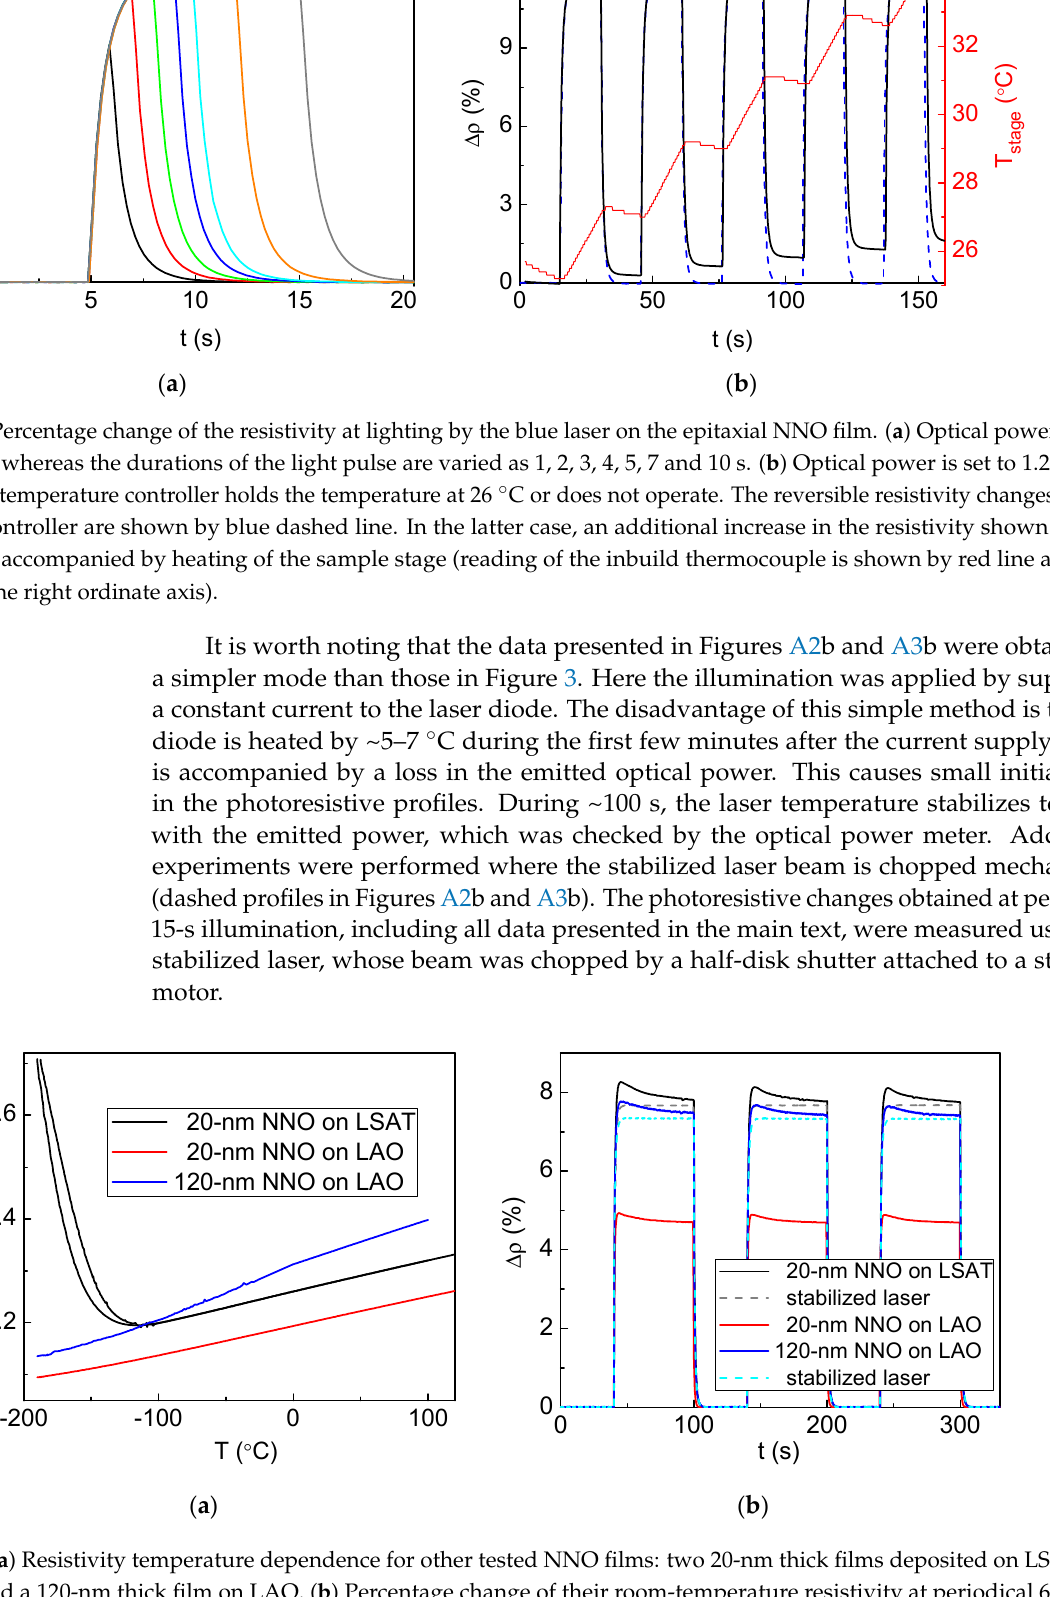
( b ) Figure A3. ( a ) Resistivity temperature dependence for other tested LNO films: two films deposited on LSAT with thick- nesses 20 and 80 nm as well as a 120-nm thick film on LAO. ( b ) Percentage change of their room-temperature resistivity at long-term illuminations by the blue laser at optical power 0.8 W. By analyzing Table A1 in general, it is evident that the magnitude of the photoresis- tive change can be tuned by a proper manufacturing of the sensitive film structure with defined values of the resistivity and its derivative d ρ /dT . However, the thermal factors, namely optical absorption and heat removal, prevail. The absorption factor of the dark perovskite films is high: ~80% for the thin 20-nm films and >90% for the thicker films (see Figure 1e). This determines a higher heating of the thicker films. A lower heating of the films on LAO is caused by its twice bigger thermal conductivity 10 W/m·K as compared to that of LSAT: 5.1 W/m·K. It is also proved by smaller slopes k of the linear fits Δ T ( P opt ) in Figure A6: 21.7 and 27.6 °C/W, respectively, for the blue light (20.1 and 24.1 °C/W for the infra-red illumination). The corresponding ratios k / α are 28.2 and 32.1 °C/W, which is very close to a half of that value obtained for the NNO film on LSAT (see Table 1).